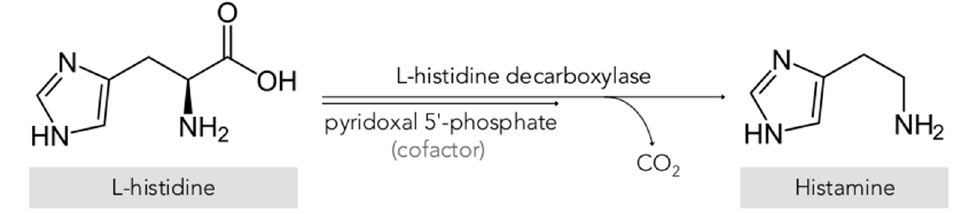
Figure 1. Synthesis of histamine by decarboxylation of its precursor amino acid.